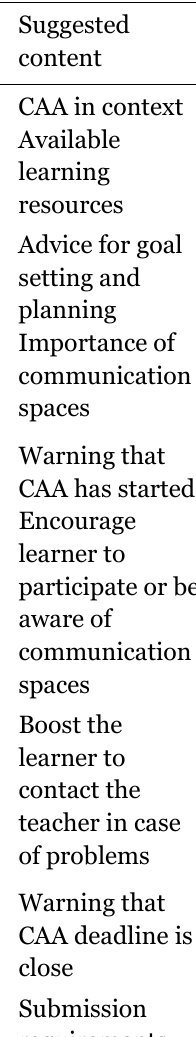
Nudges Supported by Intervention